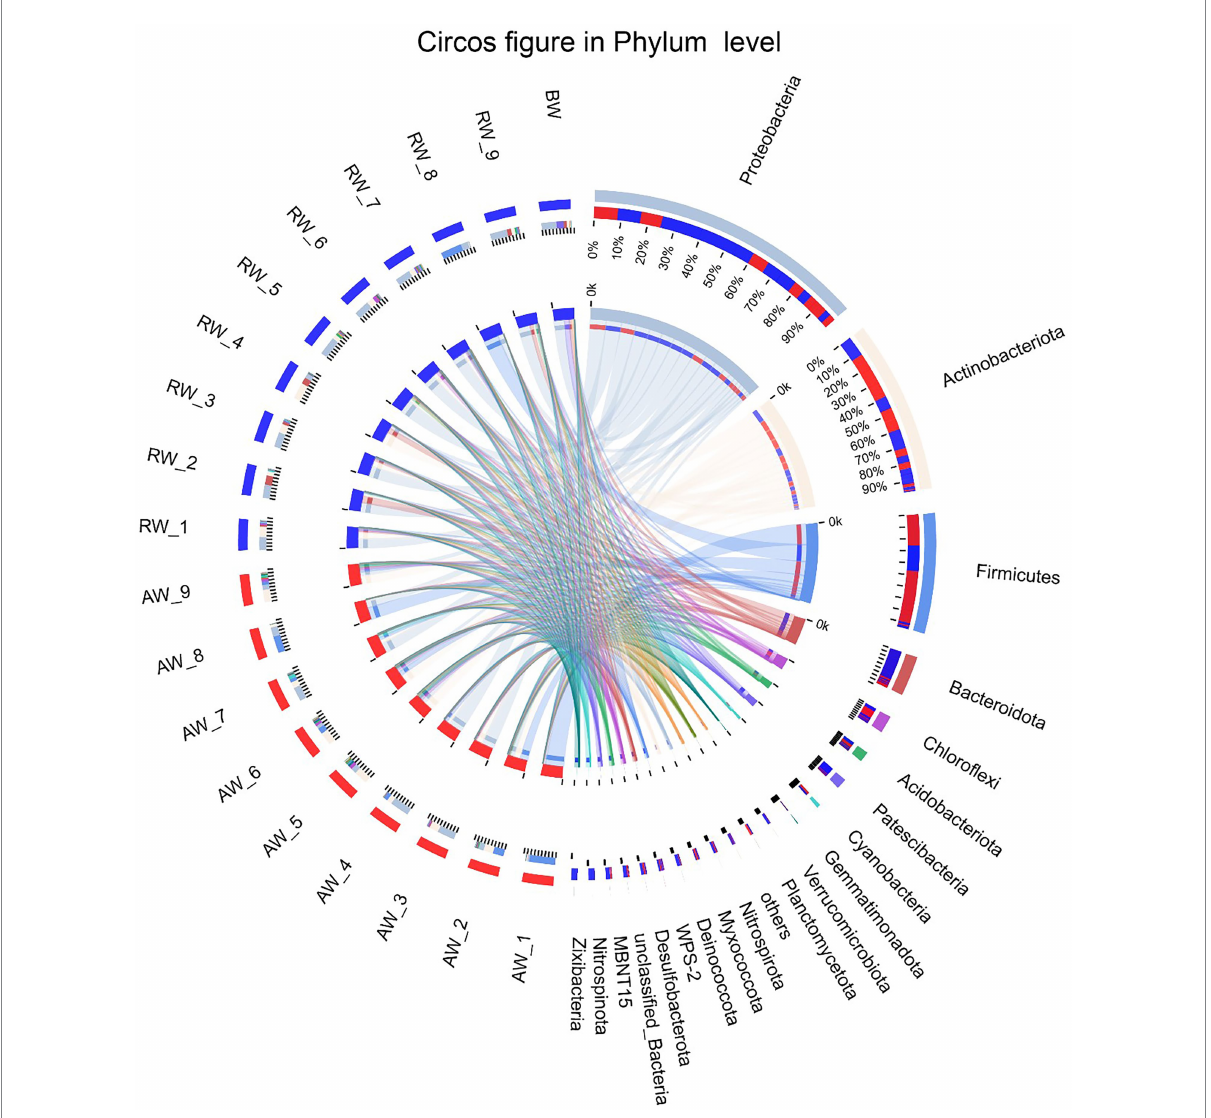
FIGURE 4 The Circos diagram of sample-taxa relationship in Phylum level. The inner circle represents the composition of taxa in the sample, the color of the inner ribbon represents the taxa, and its length represents the relative abundance of the taxa in the corresponding samples. The outer circle represents the distribution ratio of taxa in different samples at the Phylum level, the outer ribbon represents taxa, the inner ribbon color represents different groups, and the length represents the distribution ratio of the sample in a